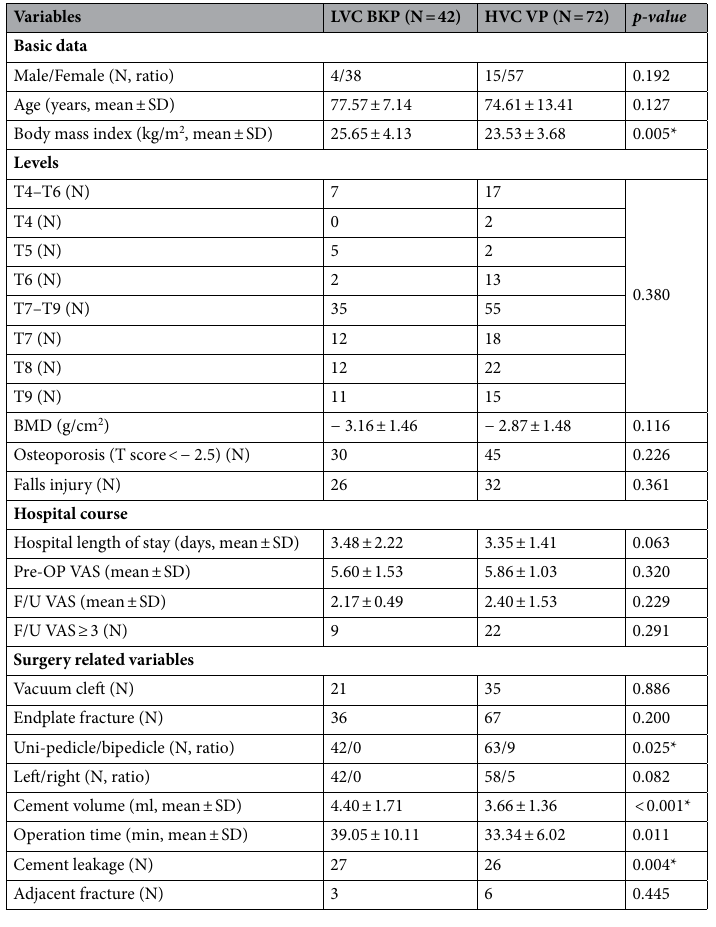
Table 1. Patient demographic data: LVC BKP versus HVC VP. LVC BKP low-viscosity cement balloon kyphoplasty, HVC VP high-viscosity cement vertebroplasty, N number, SD standard deviation, kg